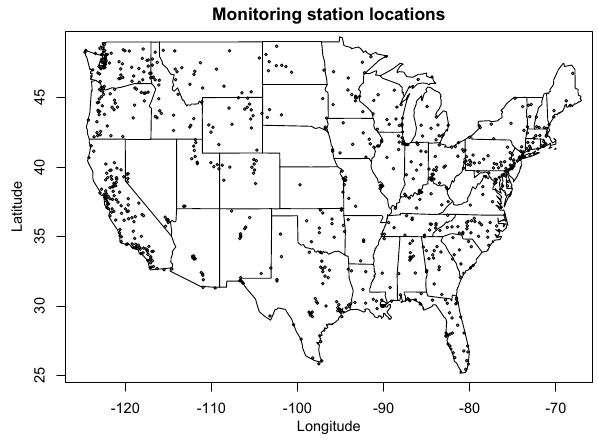
Figure 1. The 764 monitoring station locations of PM 2 . 5 within the AQS repository for the summer months of